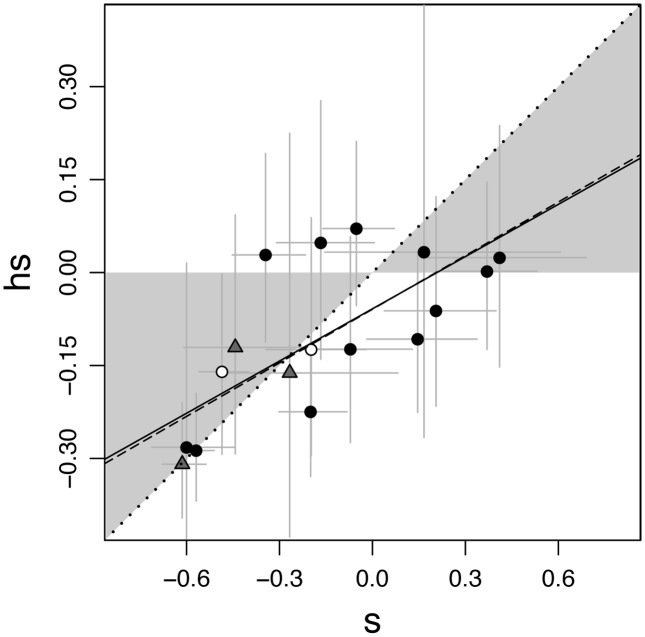
Fitness effects of mutations in heterozygous (hs) and homozygous (s) coinfections.Data are means ± standard errors of the mean. Regions where mutations have recessive effects (0< h<0.5) are shown in gray and additive effects (h = 0.5) are shown as a dotted line. The solid line is the reduced major-axis regression line and falls primarily in the recessive region. Mutations are represented as circles if they were accumulated in the φ6mindich background and as triangles if they were accumulated in φ637-F41. Removal of the two mutants that did not have mutations in P3 (white-filled circles) barely affected the major-axis regression (dashed line). Effects of P3 mutations that were obtained and measured in an alternative, higher fitness genetic background are shown with dark gray circles.